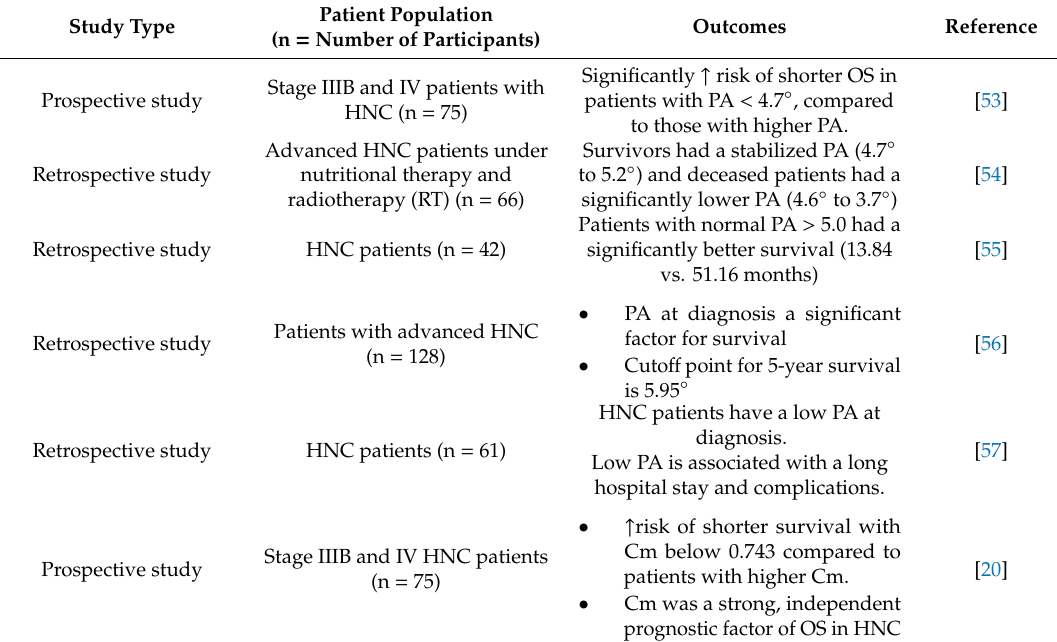
Table 2. Studies examining the prognostic role of tissue electrical properties in head and neck cancer